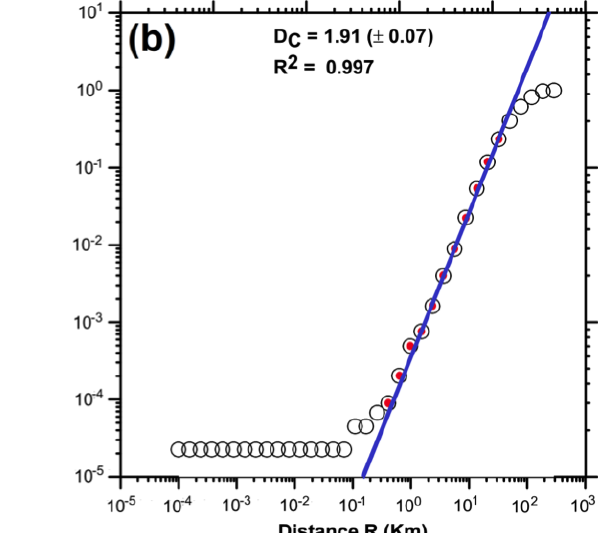
7.8) and (b) second ( M 7.2) W W